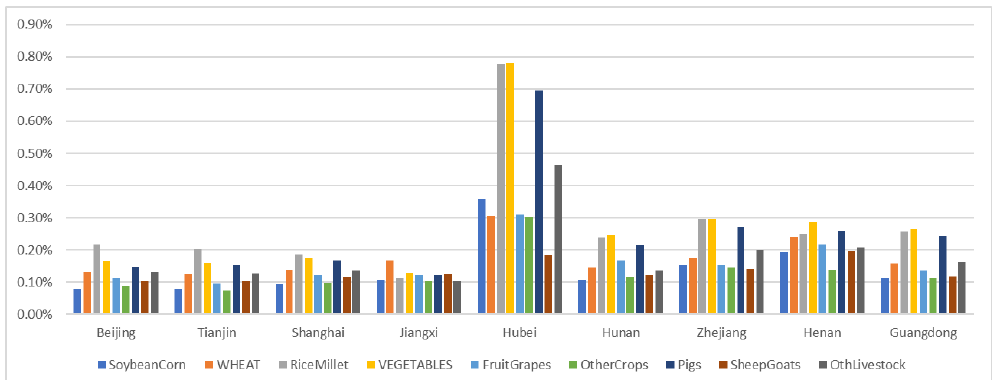
Figure 4. Changes in prices of various commodities in Beijing, Tianjin, Shanghai, Jiangxi, Hubei, Hunan, Zhejiang, Henan, and Guangdong under SIS scenario.